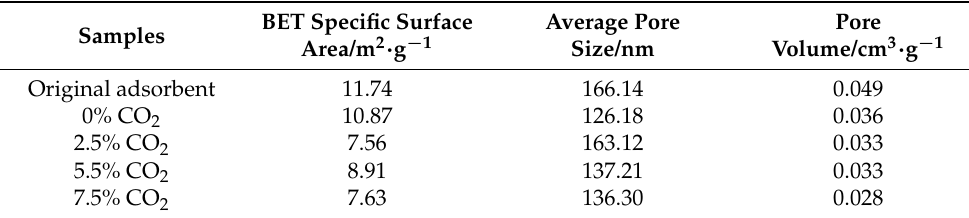
Table 3. BET and pore structure parameters of desulfurization products with different CO 2 concen- trations.